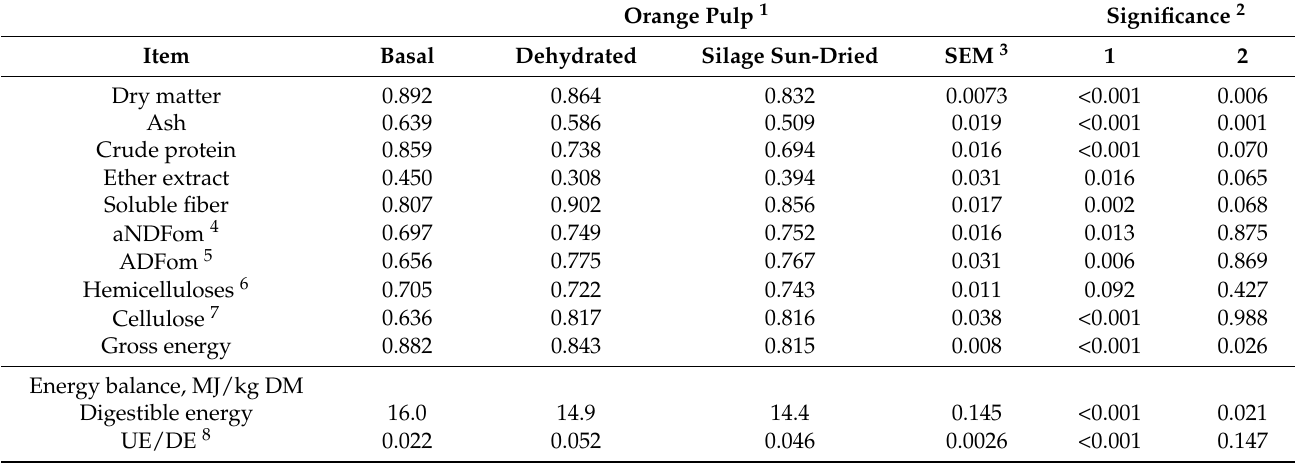
Table 4. Coefficients of apparent total tract digestibility of nutrients and energy balance of the experimental diets.